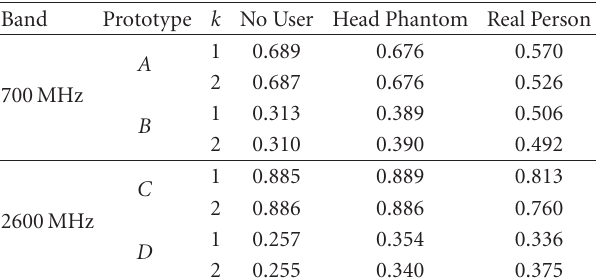
Table 3: Apparent diversity gain results